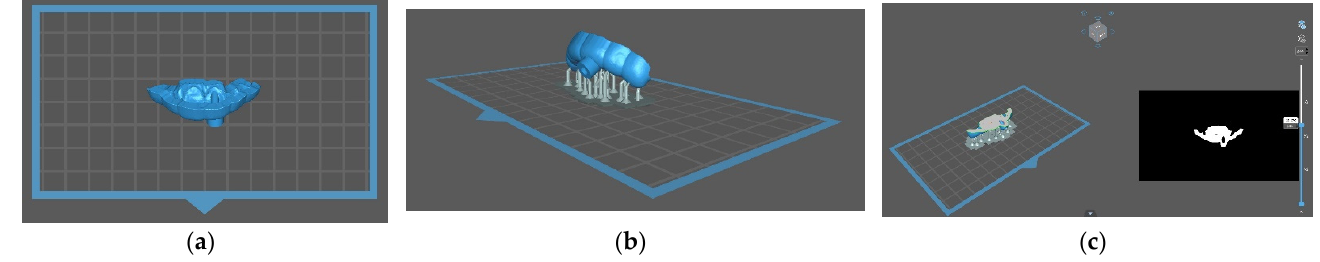
Figure 5. ( a ) STL file of the guide imported to the slicer software (Chitubox); ( b ) image after adding connectors for printing; ( c ) software showing object sliced into 50 µm layers. Each layer can be displayed and checked.